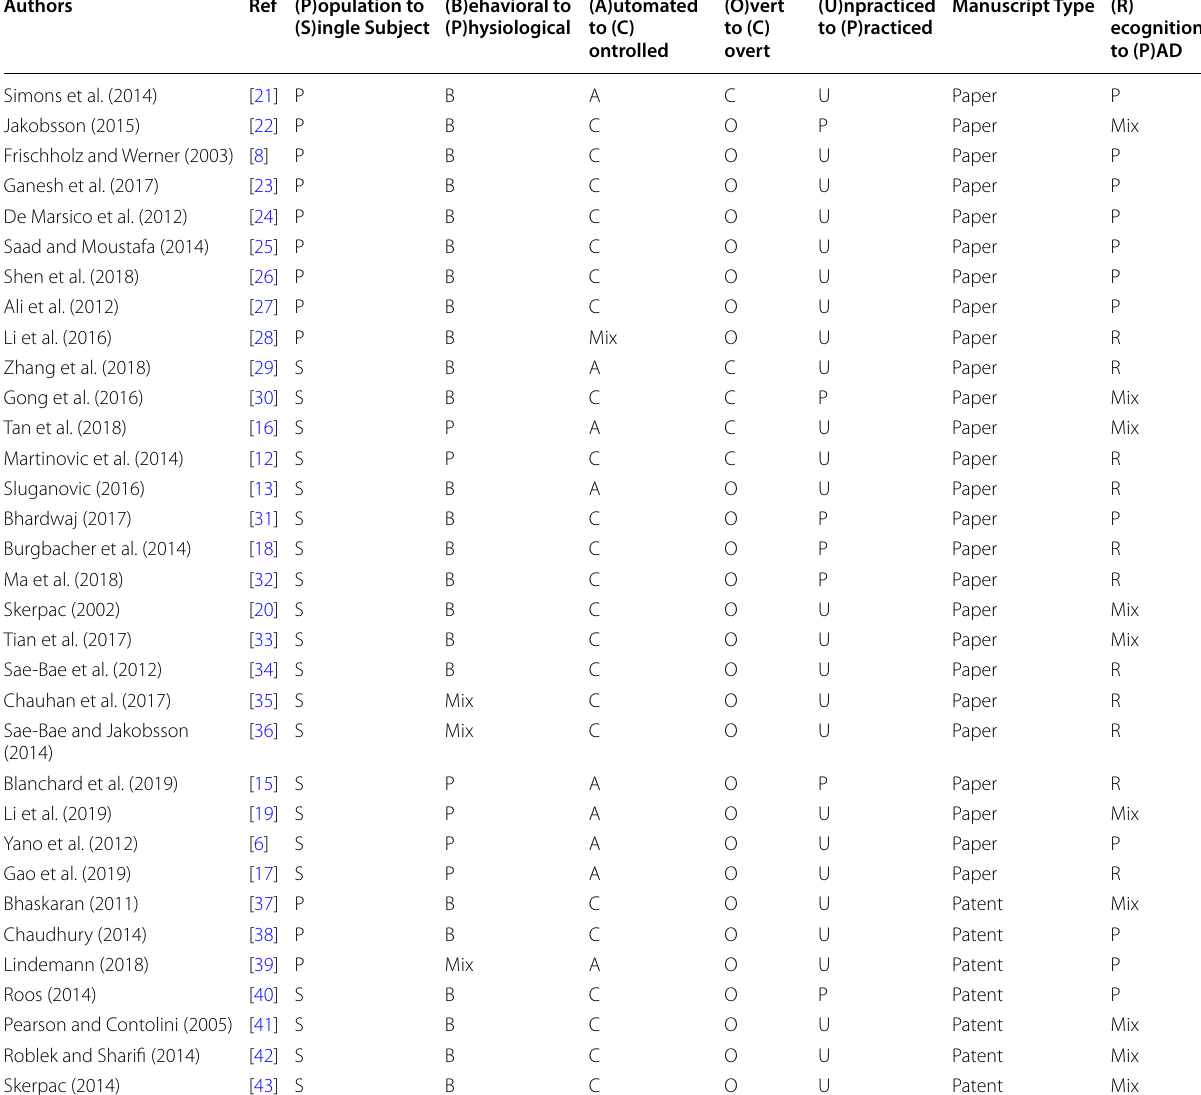
Table 2 Table of manuscripts describing biometric challenge-response protocols. The columns represent where the manuscripts fall on the 5 categories, as well as the type of manuscript and PAD or recognition intent of the described protocol